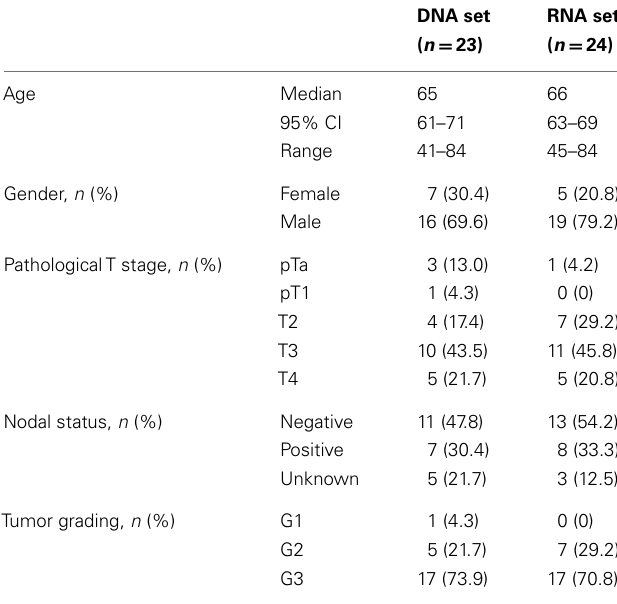
Table 1 | Clinical characterization of tissue sample